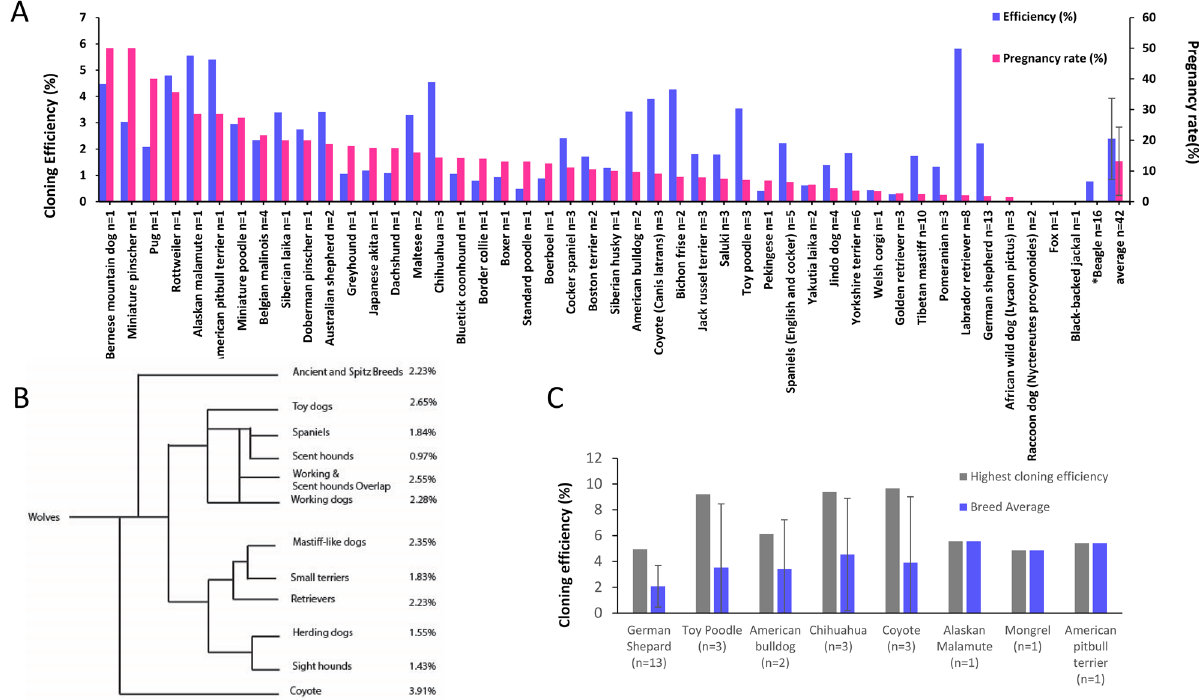
Figure 3. Cloning efficiency and pregnancy rate by breed. ( A ) Cloning efficiency and Pregnancy rate by individual breed. Averages displayed with STDEV. ( B ) A comparison of cloning efficiency by breed grouping, n ≥ 3 except for Scent hounds, Sight hounds and small terries which had an n = 2. ( C ) Examples of observed highest cloning efficiencies and their breed average. All error bars are standard